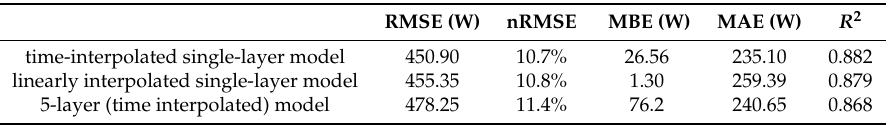
Table 1. Test results for single-layer and 5-layer LSTM